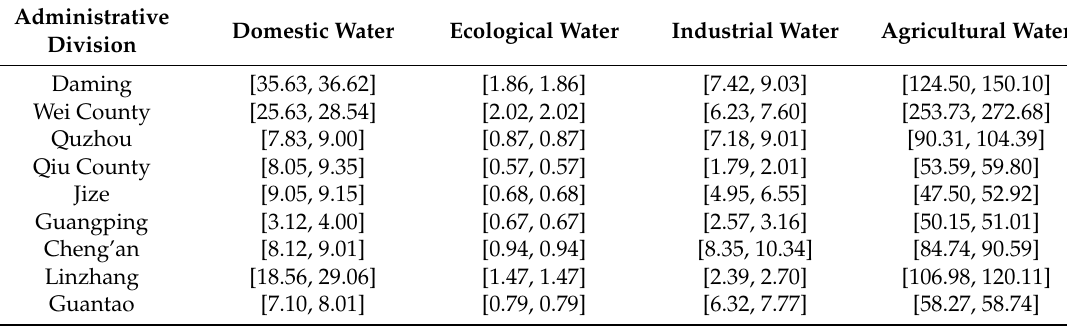
Table 9. Result of surface water allocated to every user (w i = (0.2, 0.7, 0.1)) (10 6 m 3 ).